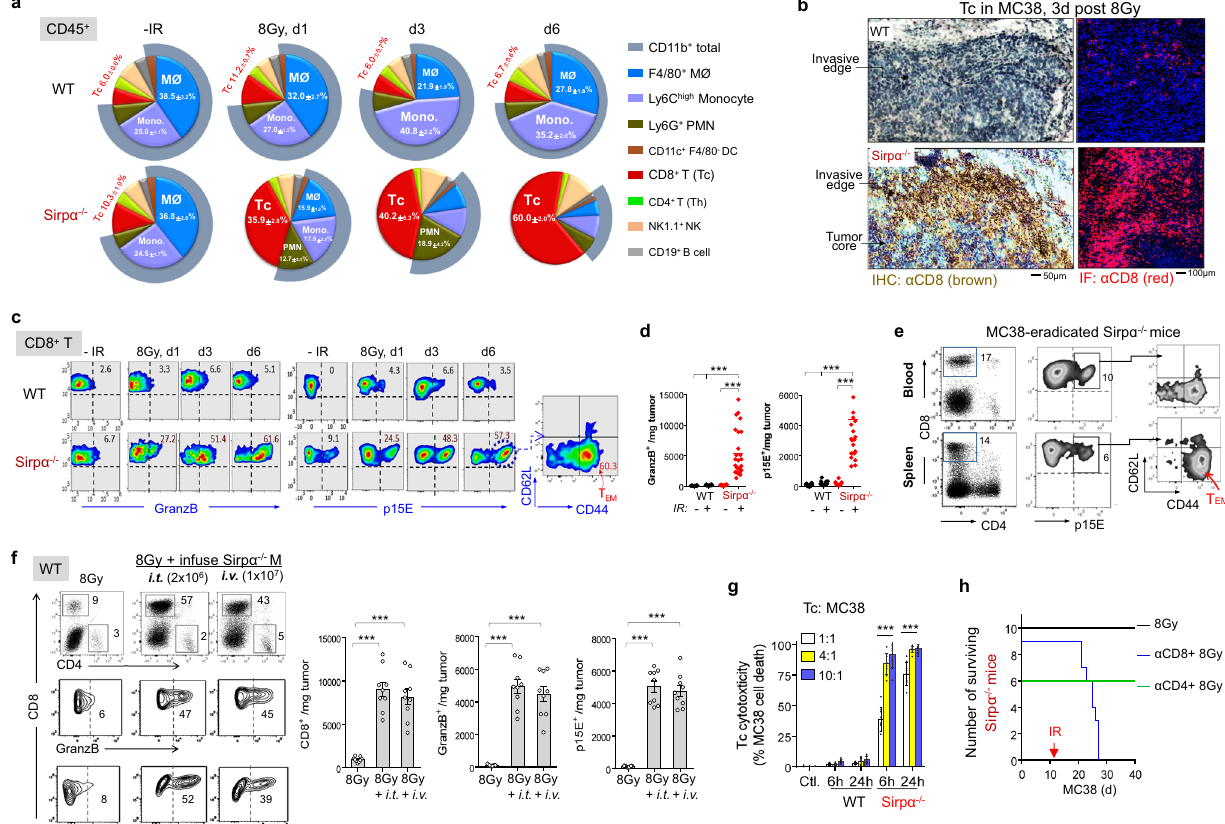
Fig. 4 Sirp α de fi ciency induces robust tumor-speci fi c Tc expansion following RT. a Frequencies of intratumoral immune cell populations before and 3 days after an 8 Gy IR. Data from fi ve independent experiments (3 – 4 mice/group in each experiment) are presented as mean ± SEM. n = 16 mice in each group. b IHC and IF staining of CD8 + Tc in MC38 tumors 3 days after IR. Data represent three independent experiments (3 mice/group in each experiment). c , d , Frequencies ( c ) and number ( d ) of granzyme B high (GranzB) and p15E + Tc in the MC38 TME before and after IR. Data are representative of fi ve independent experiments (3 – 5 mice/group in each experiment). n = 25 mice (Sirp α − / − + IR) and 16 mice (other groups). *** P < 0.001. e Frequency of p15E + Tc and p15E + CD44 + CD62L − T EM in peripheral blood and the spleen of MC38-eradicated Sirp α − / − mice. Data are representative of two independent experiments. n = 6 mice in each group. f MC38-bearing WT mice received two infusions (3-days interval) of Sirp α − / − BMDM via i.t . (1×10 4 / mm 3 tumor, total 2 × 10 6 for a 200 mm 3 tumor) or i.v . route (1 × 10 7 per mouse) followed by IR (8 Gy) after each infusion. Intratumoral p15E + and GranzB + Tc were quanti fi ed after 3 days. Data from three independent experiments (3 mice/group in each experiment) are presented as mean ± SEM. *** P < 0.001. n = 9 mice in each group. g Assaying Tc cytotoxicity in vitro. Tc from irradiated MC38 tumors of WT and Sirp α − / − mice were isolated 3 days post-IR and cocultured with MC38 cells at an indicated effector: target ratios for 6 or 24h. Real-time Tc killing tumor cells are depicted in Supplementary Movie 1. Data from three independent experiments were presented as mean ± SEM. n = 9 mice in each group. *** P < 0.001. h Depletion of CD8 Tc (by α CD8) but not CD4 Th (by α CD4) diminished RT ef fi cacy against MC38 in Sirp α − / − mice. Data represent three independent experiments. n = 10 mice (8 Gy), 9 mice ( α CD8 + 8 Gy), and 6 mice ( α CD4 + 8 Gy). *** P < 0.001. P values were calculated by one-way ANOVA with Tukey ’ s post hoc test ( d , f and g) or one-way ANOVA with log-rank (Mantel – Cox) test ( h ). Source data are provided as a Source Data fi